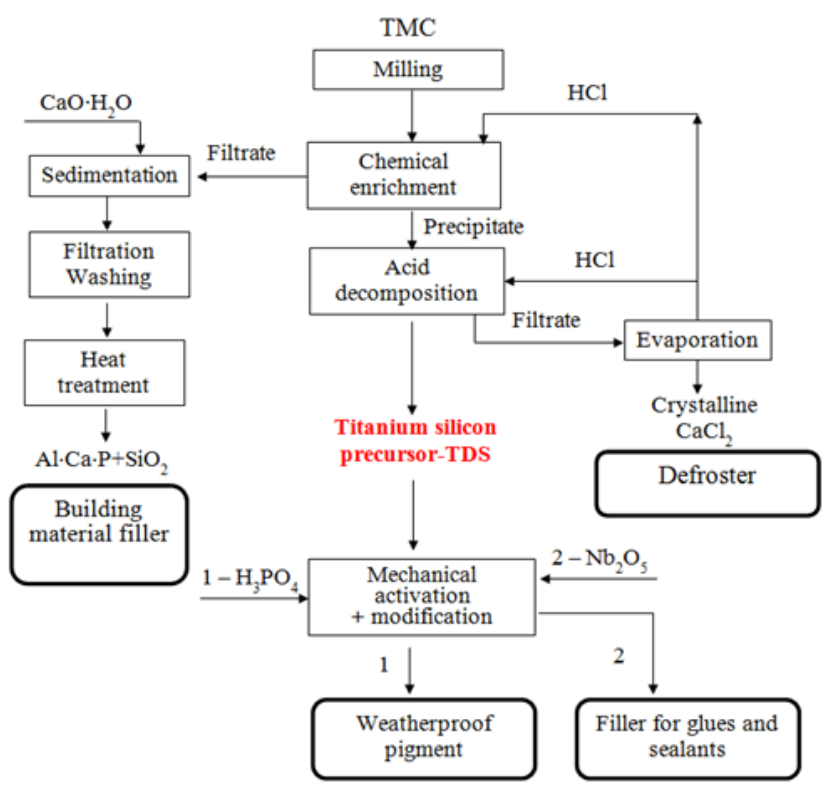
Figure 3. Technological scheme of processing titanium-containing mineral composition (TMC) to obtain weatherproof pigment and filler for glues and sealants.